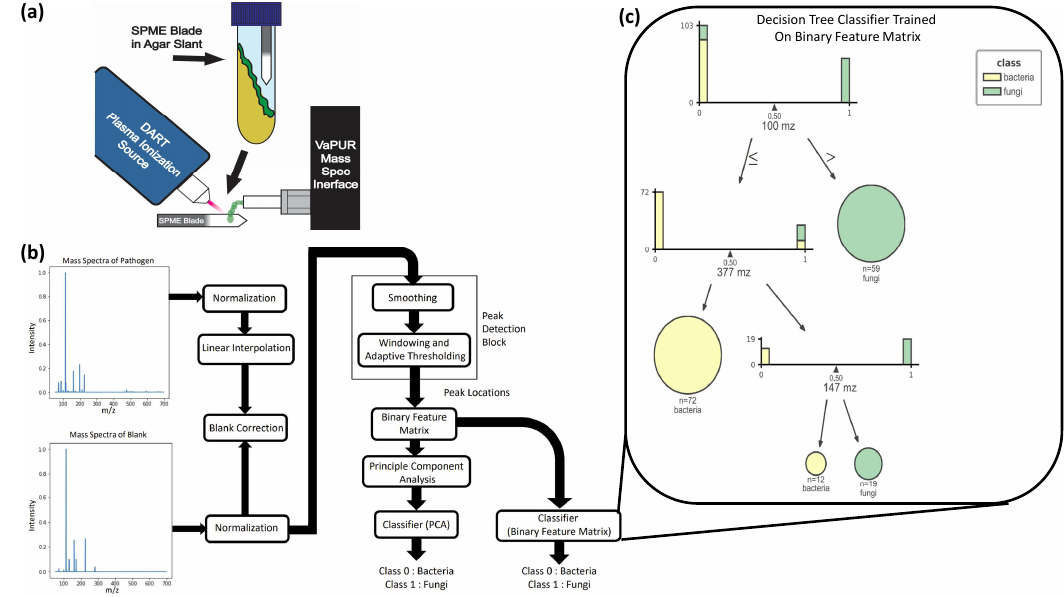
Figure 2. Study overview for identification of pathogens from skin VOCs. ( a ) Summary diagram of the SPME-DART-MS procedure. SPME blades are incubated in the headspace of the agar slant with the microbes. The blades are then removed and placed in between the plasma stream of the DART plasma ionization source and the ambient pressure interface of the mass spectrometer. VOC adhered to the SPME blade are desorbed and ionized by DART. Then, the ionized VOC enter the ambient pressure interface of the mass spectrometer for measurement to produce a signature. ( b ) Process flow diagram for MS data preprocessing, peak detection, and ML. The mass spectra of the pathogen and blank were first min-max normalized. Linear interpolation was applied to the pathogen data to match the m/z sampling frequency of the blank to facilitate the blank subtraction step. The pathogen mass spectra were then smoothed by a mean filter, after which adaptive thresholding was applied to windows of 50 m/z intervals to obtain peak locations. These are encoded into a binary feature matrix that indicates whether a peak is present in a unit m/z interval or not. A PCA transform on this matrix was used as the input to our ML classification algorithms. ( c ) Interpretation of the decision tree trained on the binary feature matrix in terms of feature importance. This figure shows the distribution of bacteria and fungi samples with respect to the peak locations of most discriminatory importance (100 m/z, 377 m/z, 147